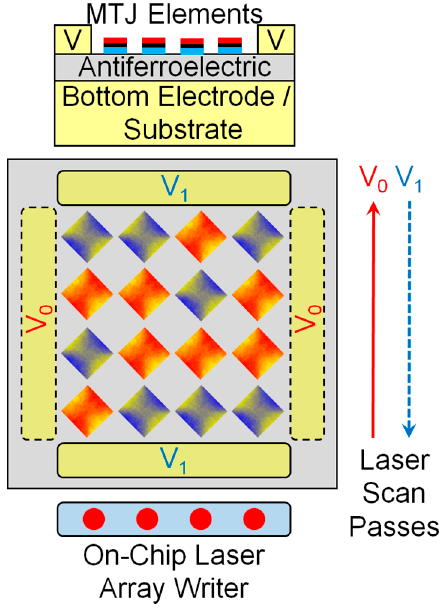
Figure 1. HAMM array. Information is stored in a patterned array of MTJ elements. Information is written using a low-power on-chip laser source and a minimal number of electrical contacts to the antiferroelectric layer, by heat-assisted stress-induced magnetisation switching. Two laser scan passes are used to write a block of information, in the first pass a voltage on the V 0 contacts generates stress to write bits “0”, whilst, in the second pass, bits “1” are written using the V 1 contacts. Heat pulses are delivered to the elements by the laser source as required during the scan passes.